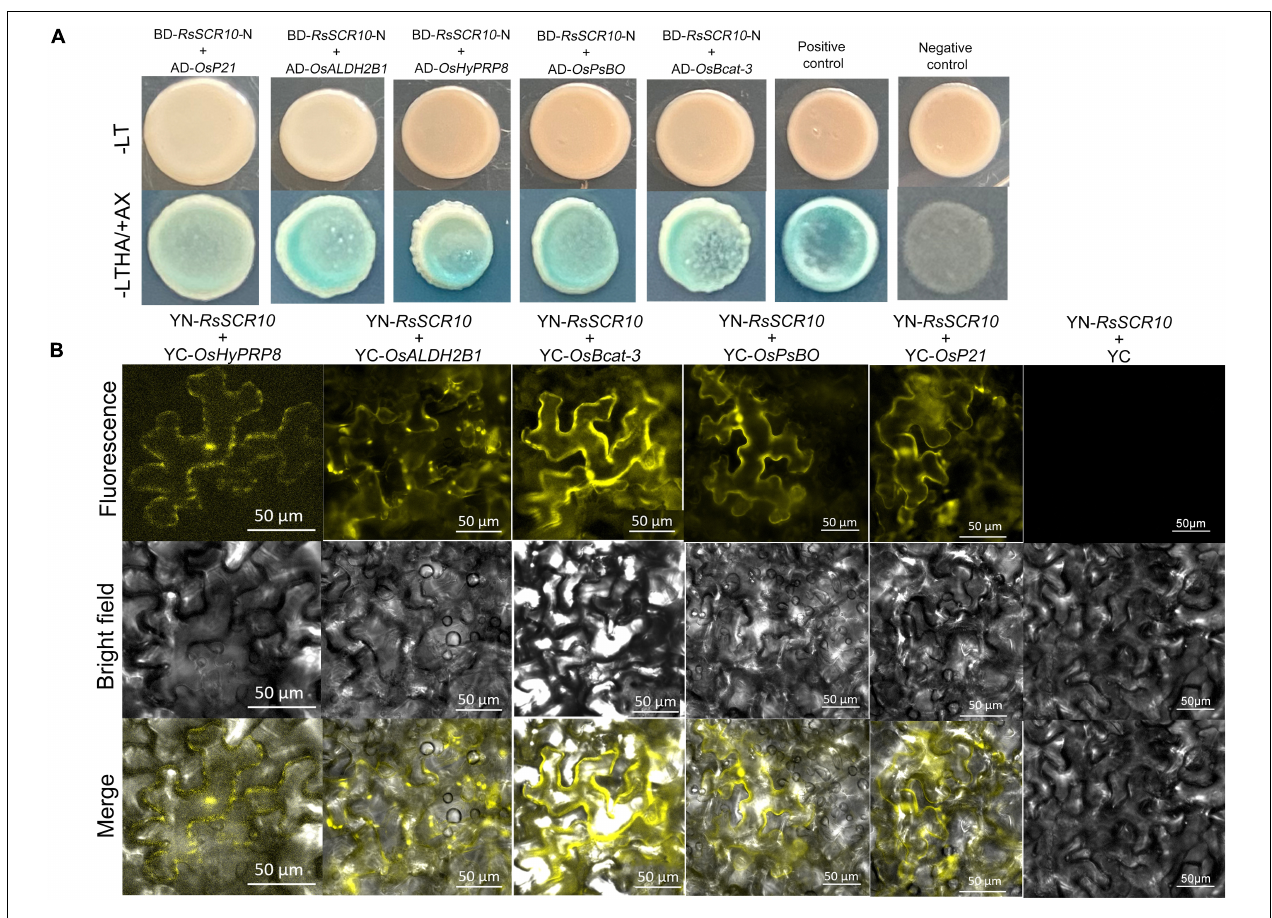
FIGURE 8 | RsSCR10 interacts with five rice proteins. (A) Yeast two-hybrid assay showing the interaction of RsSCR10 with five rice proteins. pGBKT7-lam + pGADT7-TB and pGBKT7-53 + pGADT7-T were used as negative and positive controls, respectively. Murine p53 fused to GAL4 DNA BD and the SV40 large T-antigen fused to GAL4 DNA AD were used as the positive control pair. Lamin fused to GAL4 DNA BD and the SV40 large T-antigen fused to GAL4 DNA AD were used as the negative control pair. The N-terminus of RsSCR10 (RsSCR10-N) was used for interaction analysis to exclude the transcriptional activation activity of RsSCR10. (B) Bimolecular fluorescence complementation analysis of the interactions between RsSCR10 and five rice proteins. Bars, 50 µ m. RsSCR10 fused to the N-terminal fragment of yellow fluorescent protein (YFP) and the C-terminal fragment of YFP were used as the negative control pair (YN-RsSCR10 + YC). All experiments were repeated at least three